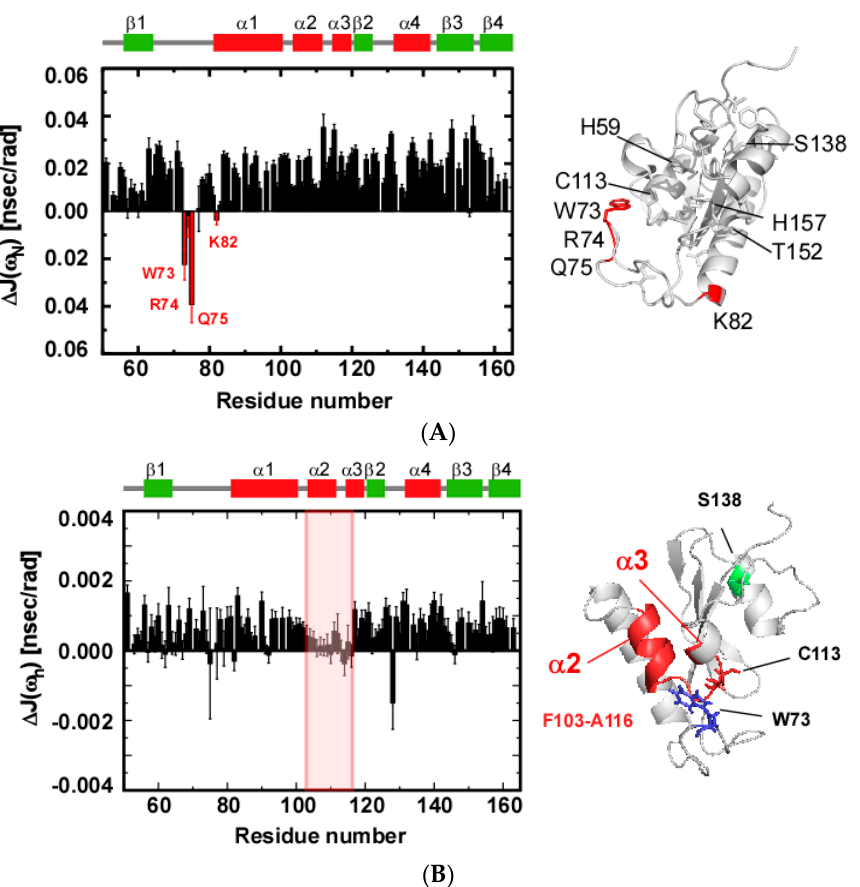
Figure 6. S138A mutation induced changes in structural dynamics. ( A ) Differences in spectral density function J ( ω N ). The difference was calculated for each residue as Δ J ( ω N ) = J ( ω N ) S138A − J ( ω N ) wild − type , where J ( ω N ) S138A and J ( ω N ) wild − type are the values for the S138A mutant and the wild-type protein [13], respectively. Residues with negative values are labeled and marked in red. In the left panel, residues with negative Δ J ( ω N ) are colored red. The conserved hydrophobic residues, S138 and the hydrogen-bonding network residues are modeled as sticks. ( B ) Differences in spectral density function J ( ω h ). The difference was calculated for each residue as Δ J ( ω h ) = J ( ω h ) S138A − J ( ω h ) wild − type , where J ( ω h ) S138A and J ( ω h ) wild − type are the values for the S138A mutant and the wild-type protein [13], respectively. The region, F103–A116, with values lower than other parts is orange-boxed (right). The region, F103–A116, W73 and S138 are shown in red, blue and green, respectively (left).